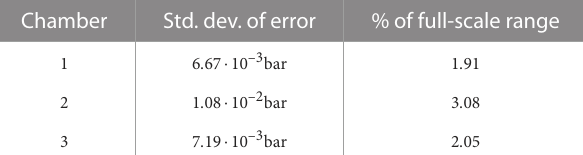
TABLE3 Standarddeviationofthedifferencebetweenthefittedcurvesand themeasuredcharacterizationdata. Chamber Std. dev. of